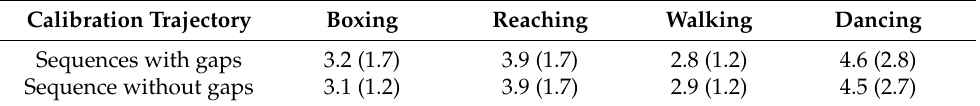
Table 3. Summary of the performance of our method per activity using the sequences with gaps and the original sequences (without gaps) as calibration trajectories during initialization. Mean (standard deviation) of RMSE are presented in